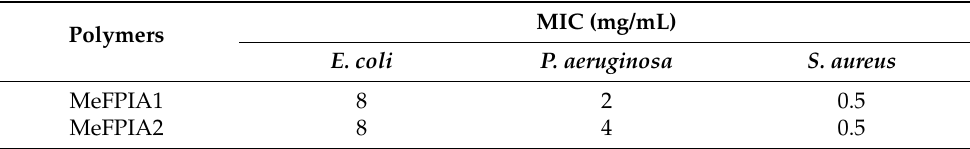
Table 6. Minimal inhibition concentration (MIC) values (mg/mL) of the quaternized polymers MeFPIA1 and MeFPIA